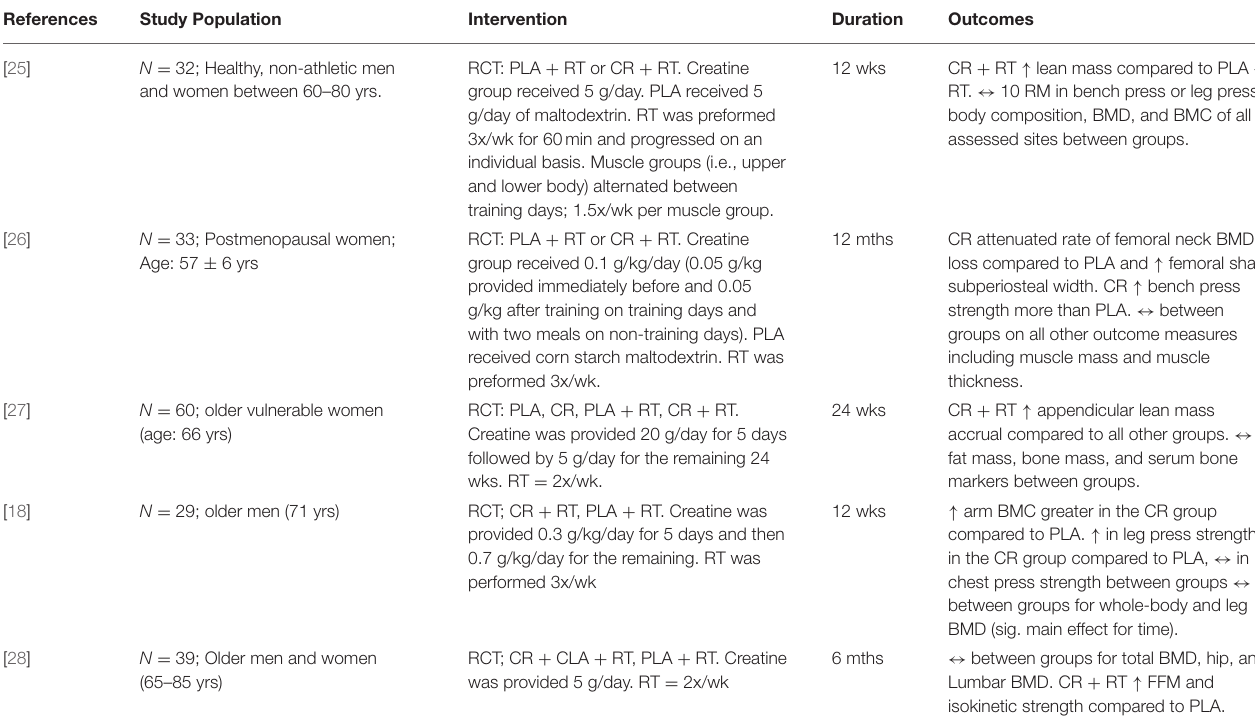
TABLE 1 | Study characteristics and outcomes of research examining the influence of creatine with a resistance training program on